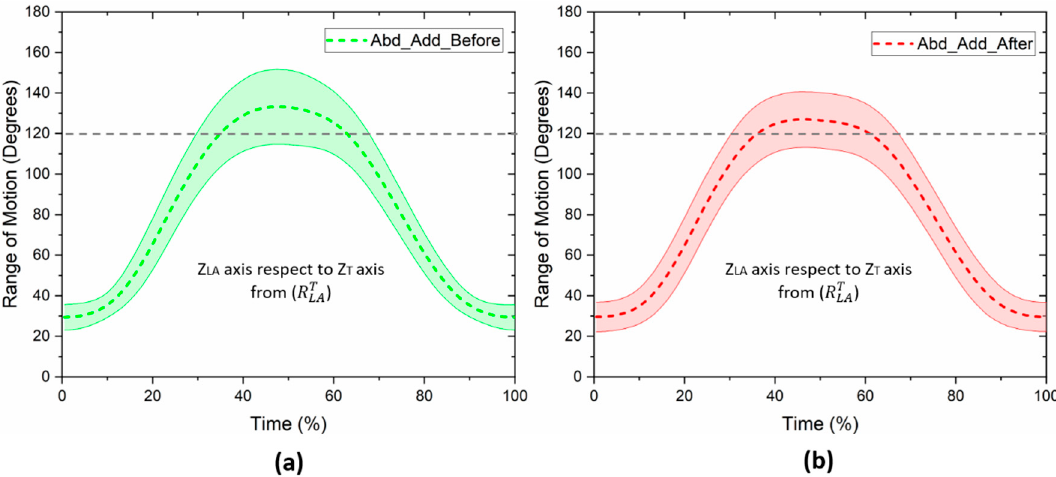
Figure 4. Mean and standard deviation of the range of motion of the glenohumeral joint, before and after breast cancer surgery: ( a ) abduction–adduction before mastectomy; ( b ) abduction–adduction → z LA axis of the arm with respect to the after mastectomy. Movement of the from R T . LA